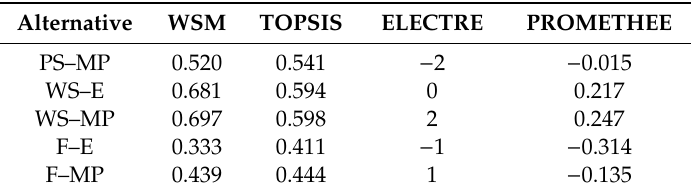
Table 7. Scores (equal weighted considering hierarchy) of wood-based residential heating